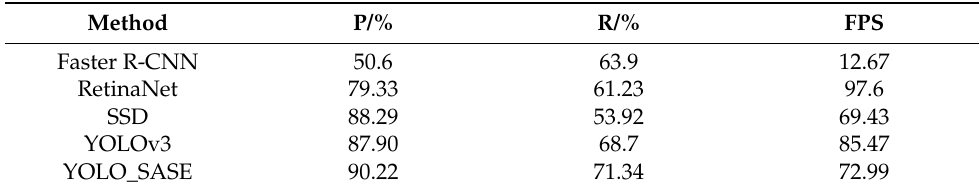
Table 5. Results of different detection